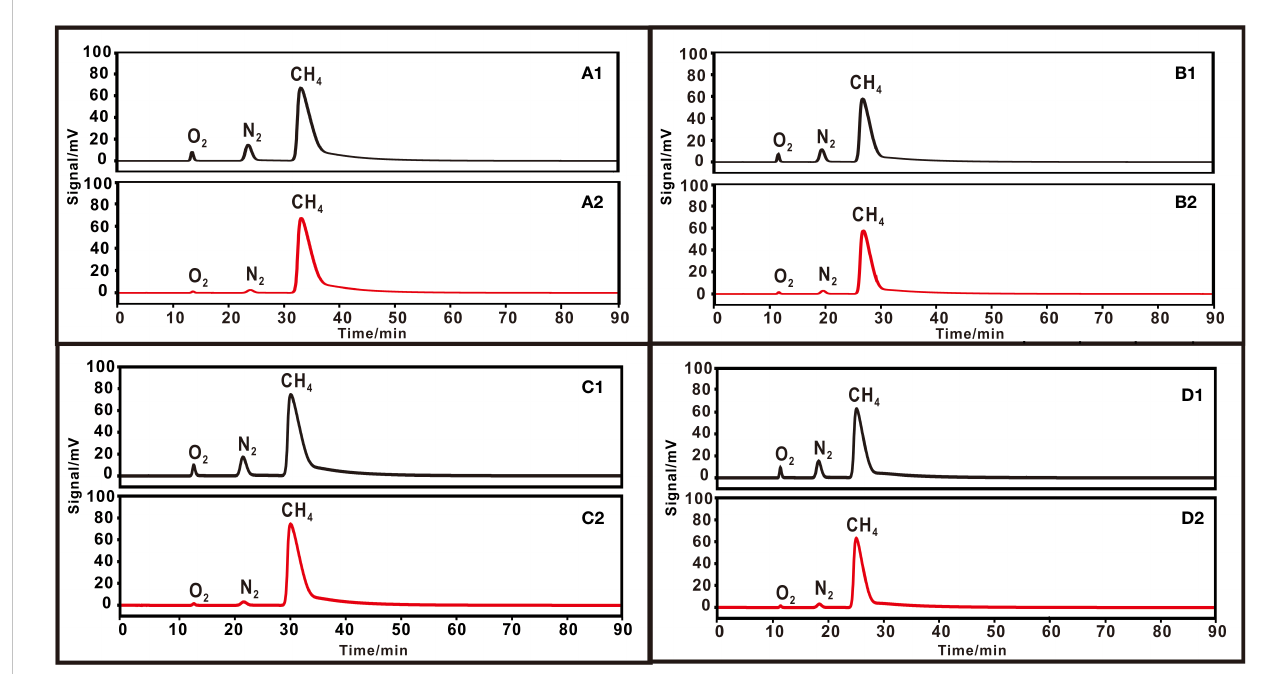
FIGURE 8 Chromatograms of 90% methane +10% air under different chromatography conditions. (A) Oven temperature 25 °C, carrier pressure 150 kPa, and fl ow rate 50.8 ml min – 1 for (1) initial gas and (2) puri fi ed gas. (B) Oven temperature 25 °C, carrier pressure 200 kPa, and fl ow rate 76.0 ml min – 1 . (C) Oven temperature 30 °C, carrier pressure 150 kPa, and fl ow rate 50.0 ml min – 1 . (D) Oven temperature 30 °C, carrier pressure 200 kPa, and fl ow rate 74.8 ml min – 1 .